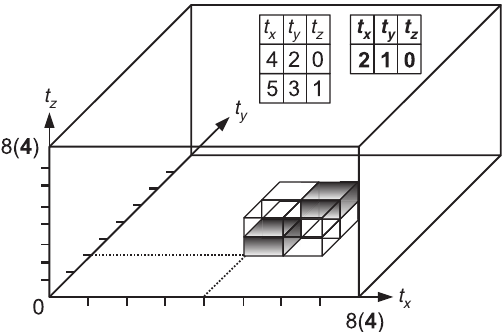
Figure 1: Partition tables for s = 8 and s = 4. Eight boxes are shown, two of which (shaded) contain elements of the